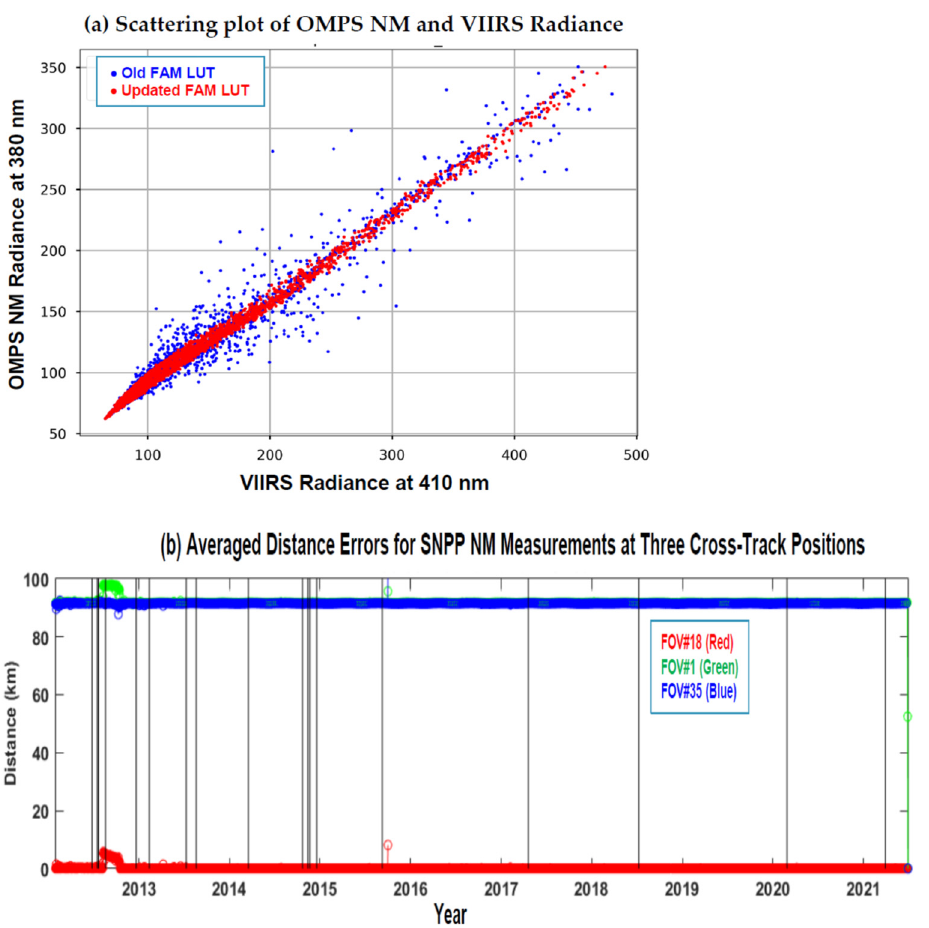
Figure 5. ( a ) Scattering plot of OMPS radiance at 380 nm and VIIRS radiance at 410 nm with (red dots)/without (blue dots) the update of the FAM LUT. ( b ) Time series of averaged distance errors for SNPP OMP NM measurements at three cross-track positions over the area with latitudes greater than 60°: leftmost pixels with FOV #1; nadir pixels with FOV #18; rightmost pixels with FOV #35. The distance error represents the distance difference between the OMPS data at the same cross-track position with the updated and old versions of the FAM LUT.